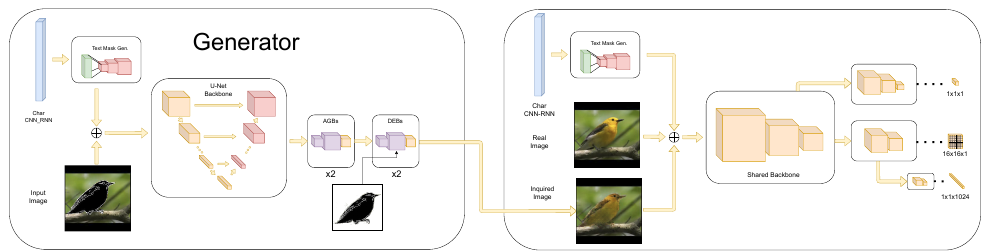
Figure 2. The overall architecture of aRTIC GAN. The orange blocks represent the convolutional layers and the red ones symbolize the transposed convolutional layers, while the green and purple represent the fully connected and bilinear upsampling blocks,